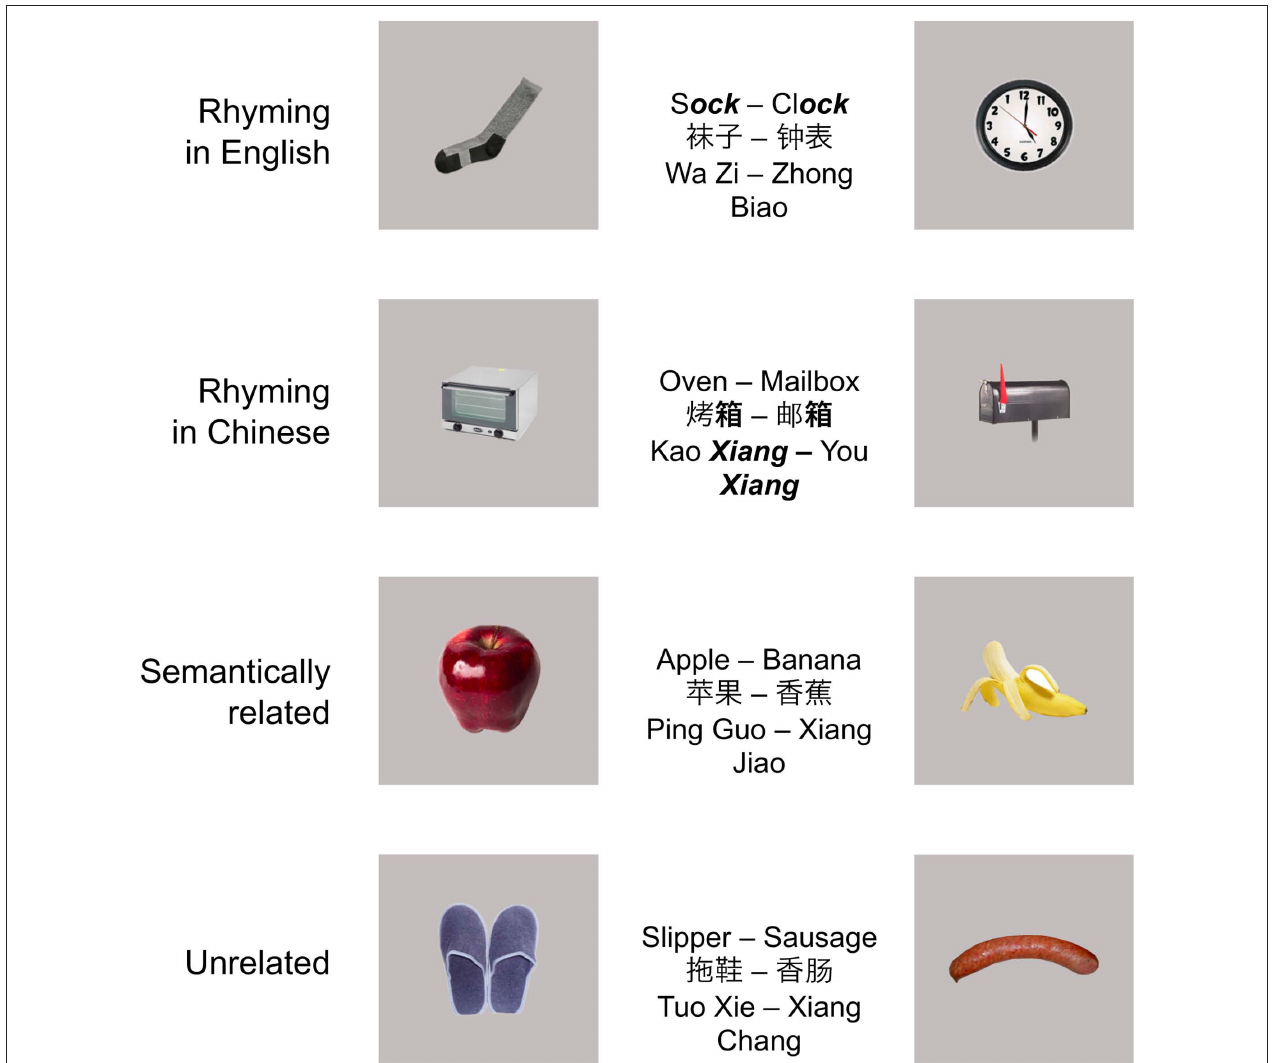
FiguRE 1 | Examples of stimuli used in the rhyming judgment tasks. Each cell contains one example of a picture pair used in the English and Chinese tasks, its English names, its simplified Chinese translations, and the corresponding Chinese Pin Yin (alphabetic transposition of the phonological form). As compared to English, Chinese characters that rhyme seldom bear overlaps in written forms (i.e., orthography). To prevent the potential confounding effects of orthographic variability on picture naming (Weekes et al., 2005; Bi et al., 2009; Zhang et al., 2009), we used Chinese words that shared a character repetition in both phonology and orthography, forming a “rhyming”